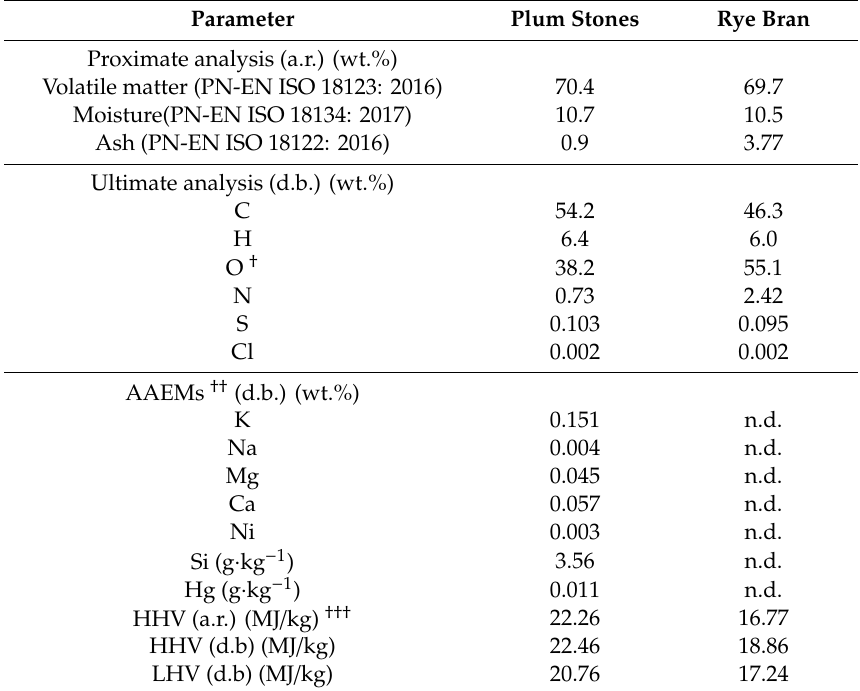
Table 1. Physicochemical properties of plum stones and rye bran.